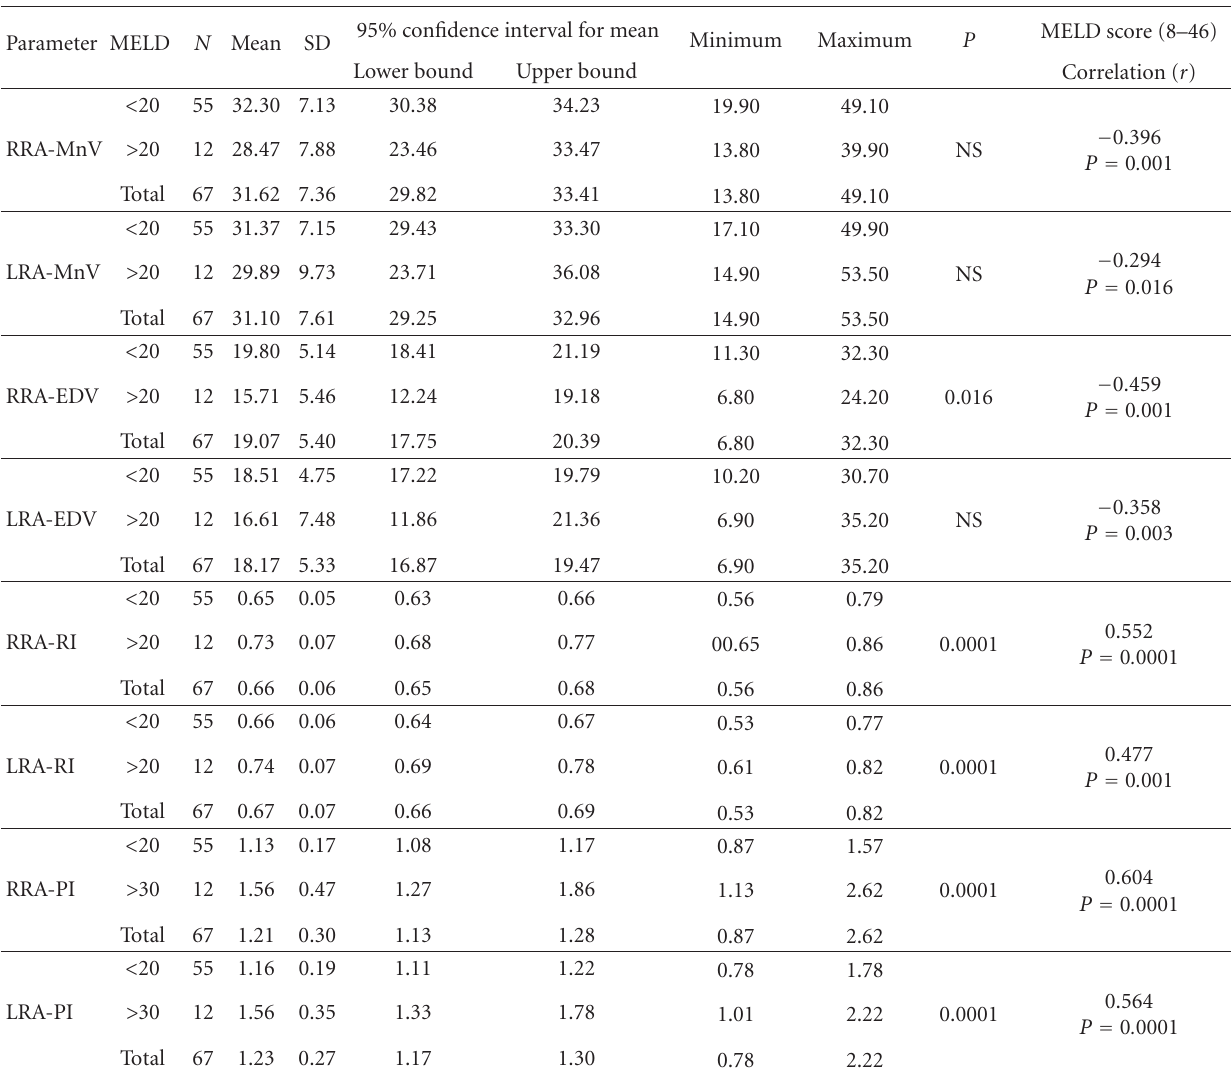
Table 5: Renal Doppler US parameters in patients with liver cirrhosis according to MELD